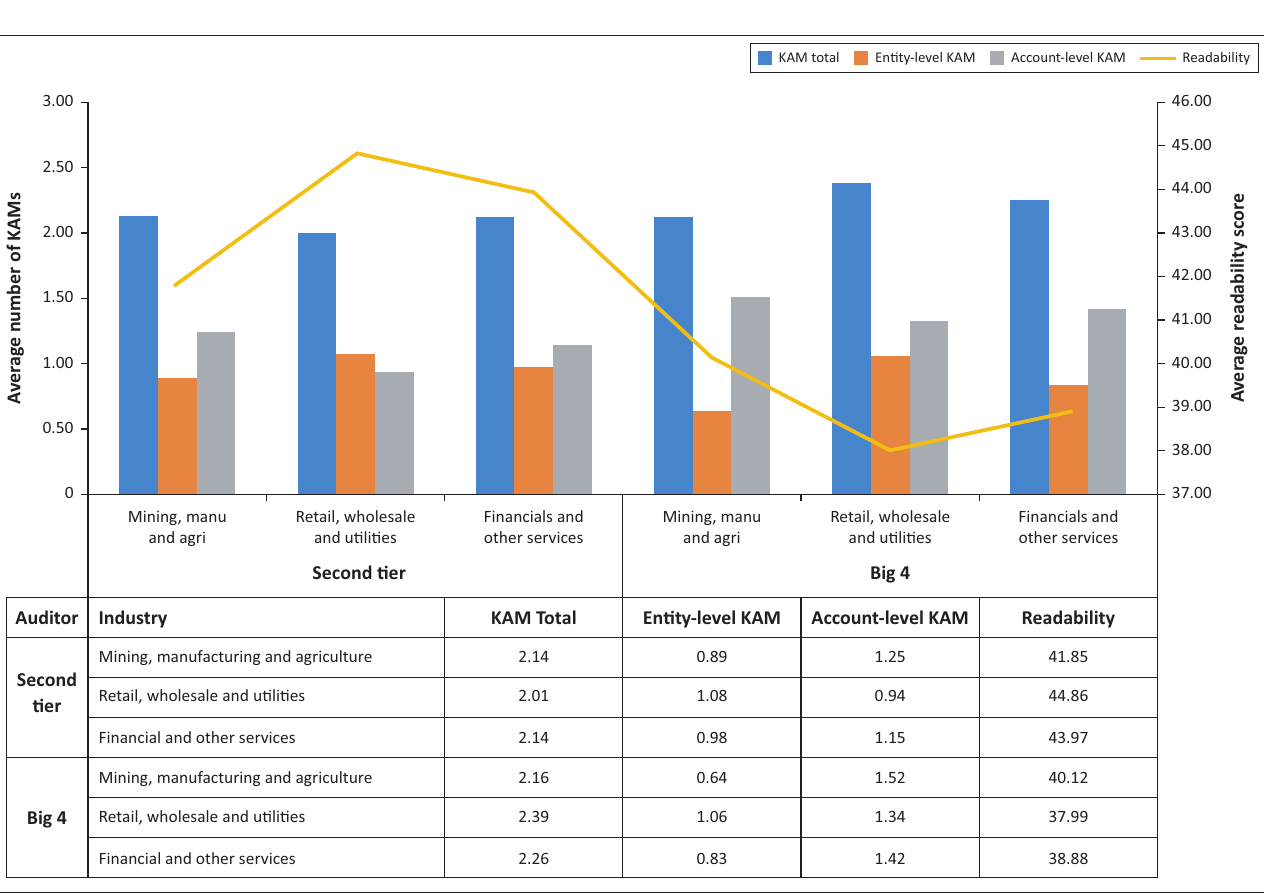
FIGURE 6: Estimated marginal means